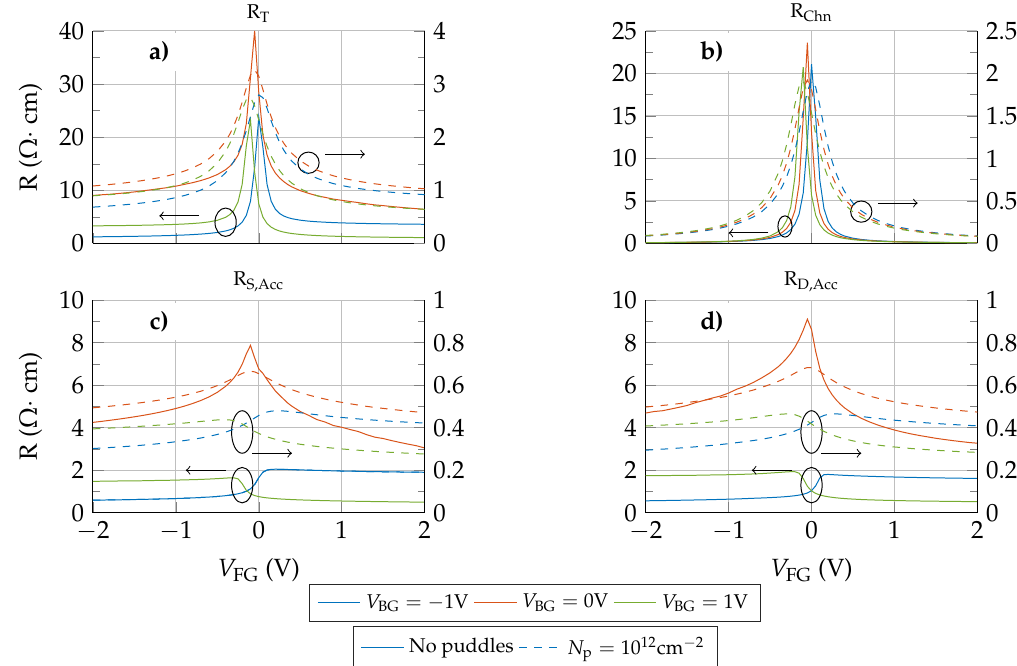
Figure 7. Total ( a ), channel ( b ), source ( c ) and drain ( d ) resistances for different back gate biases and V DS = − 0.1 V. Solid lines (referred to the left axis) correspond to the no puddles scenario while dashed lines (referred to the right axis) depict the values obtained when a puddle concentration of N p = 10 12 cm − 2 is